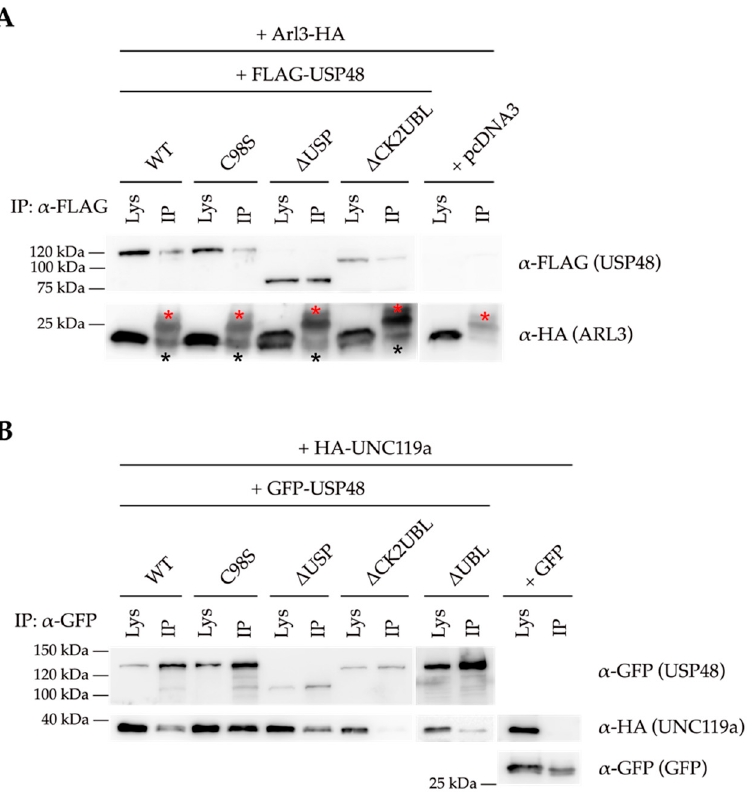
Figure 7. Different domains of USP48 are required for stabilisation of ARL3 and UNC119a. Co-immunoprecipitation using different GFP-USP48 deletion constructs shows that ( A ) the C-terminal domains of USP48 are not required for the interaction with ARL3-HA, and ( B ) the most C-terminal domains (the regulatory CK2 and UBL domains) are responsible for the interaction of USP48 with HA-UNC119a. Note that ARL3 (approx. 23 kDa, indicated by a black asterisk) has a similar molecular weight to the light IgG chains (red asterisk). Lys, lysate; IP, immunoprecipitate.